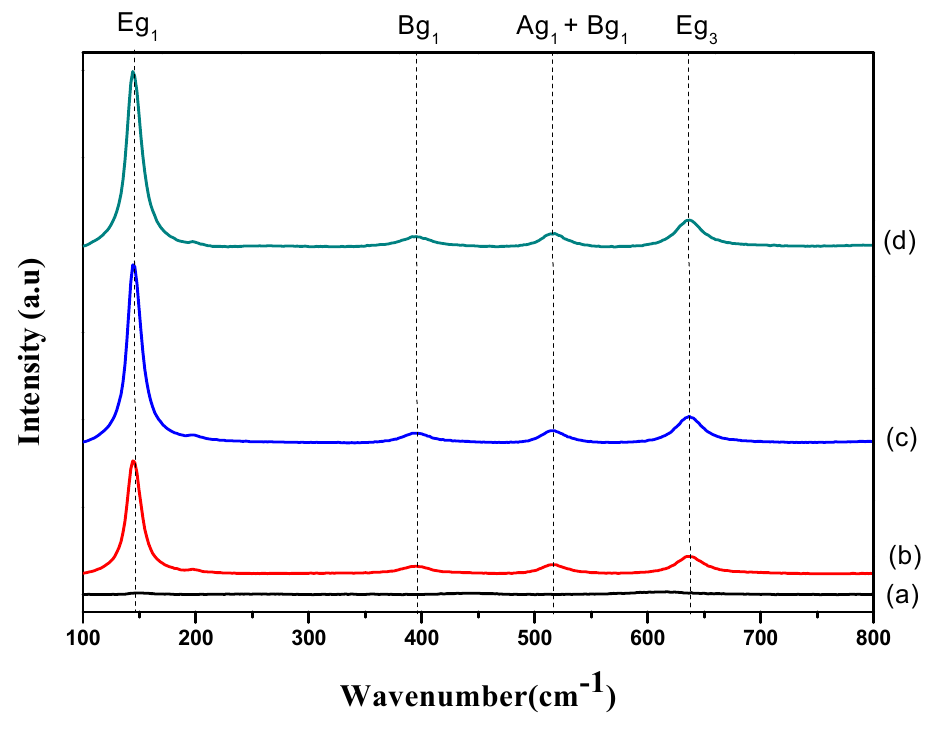
Figure 5. Raman spectra of ( a ) 30 s, ( b ) 10 min, ( c ) 20 min and ( d ) 60 min samples.